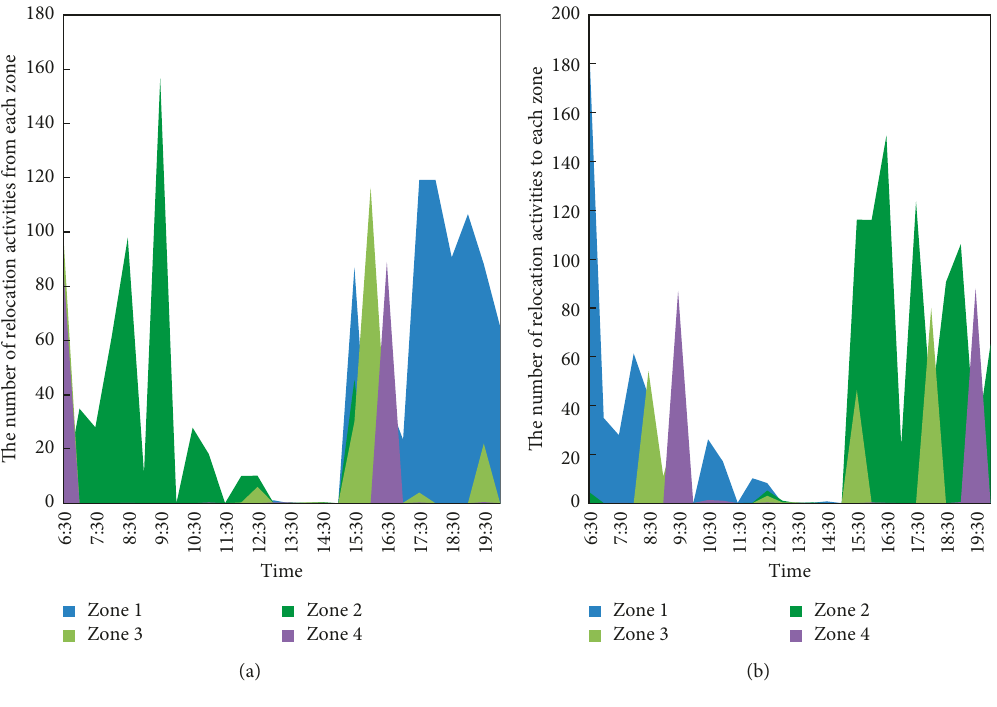
Figure 8: The distribution of relocation activities in a small network.